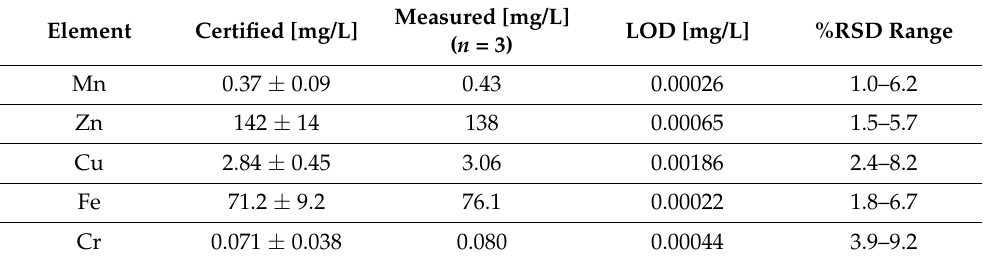
Table 1. Analysis of reference material Bovine Muscle NIST-SRM 8414.